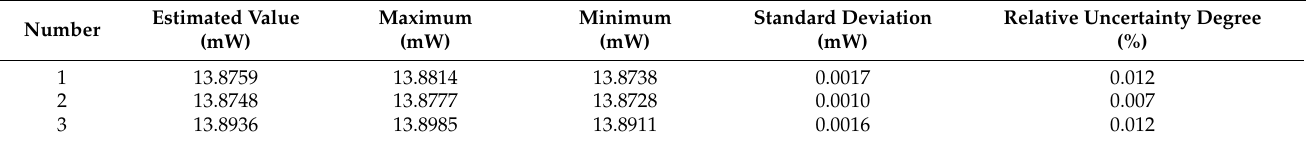
Figure 12. Variation in the total energy received with time during the PD gaze time in Experiment 1. Table 3. The relative uncertainty of PD stability in Experiment 1.